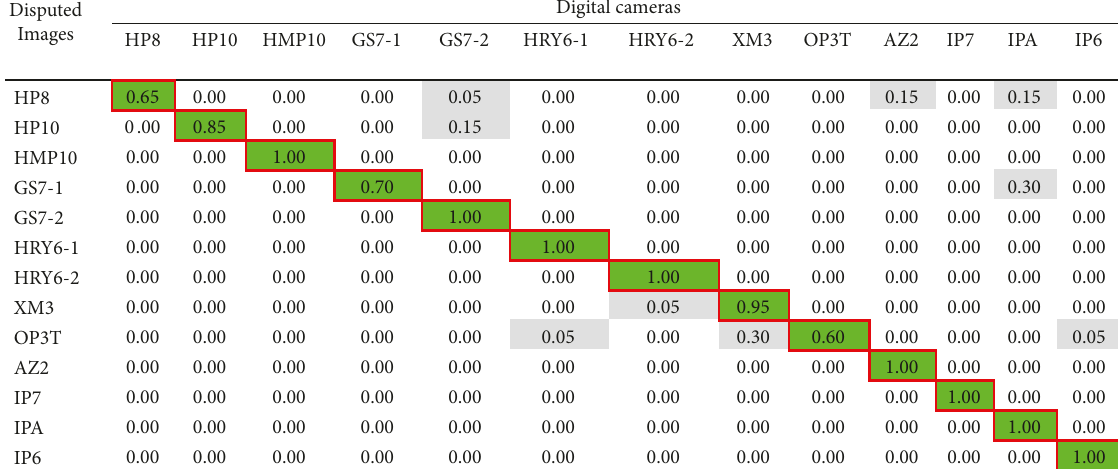
Table 4: Effectiveness of the proposed method when it is applied to the first case study (reference and disputed images are flat images). In this experiment, only full flat images as disputed images were included. Disputed Images